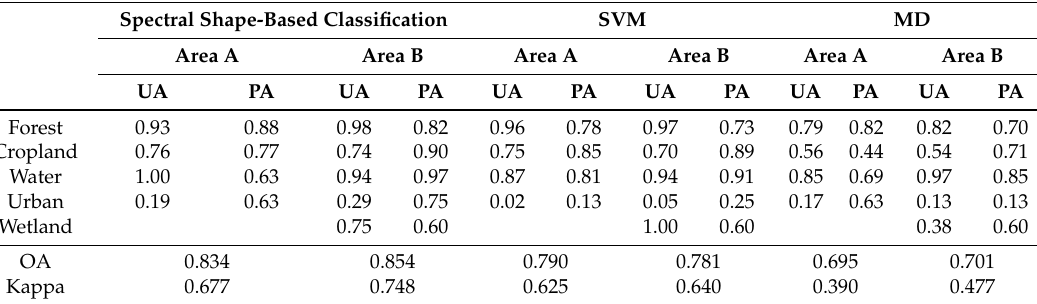
Table 13. Comparison of accuracy measurements for areas A and